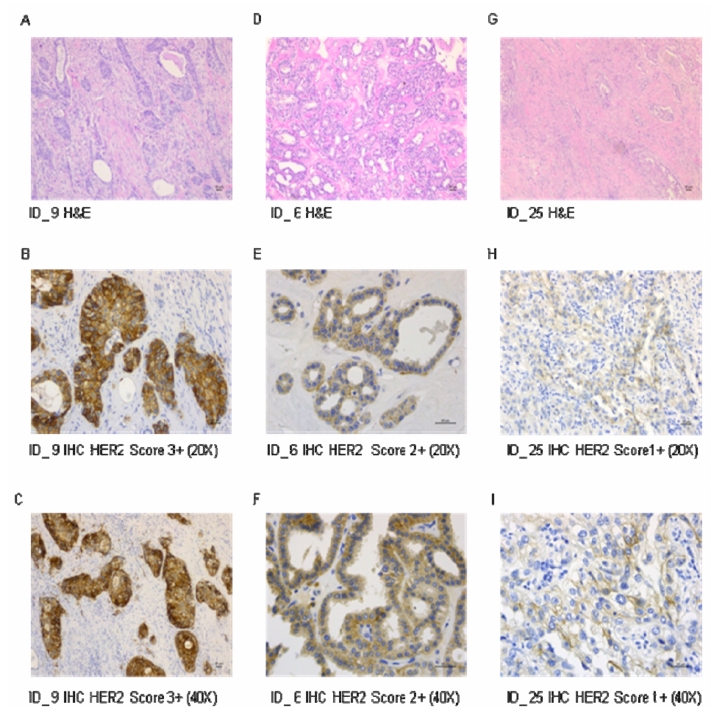
Figure 1. Representative images of H&E staining and IHC analysis in CDC. ( A ) primary tumor withtubulocystic growth pattern. (H&E, × 100). ( B ) Score 3 + HER2 immunohistochemical staining ( × 20); ( C ) ( × 40); ( D ) primary tumor with tubulopapillary pattern (H&E, × 100), ( E ) Score 2 + HER2